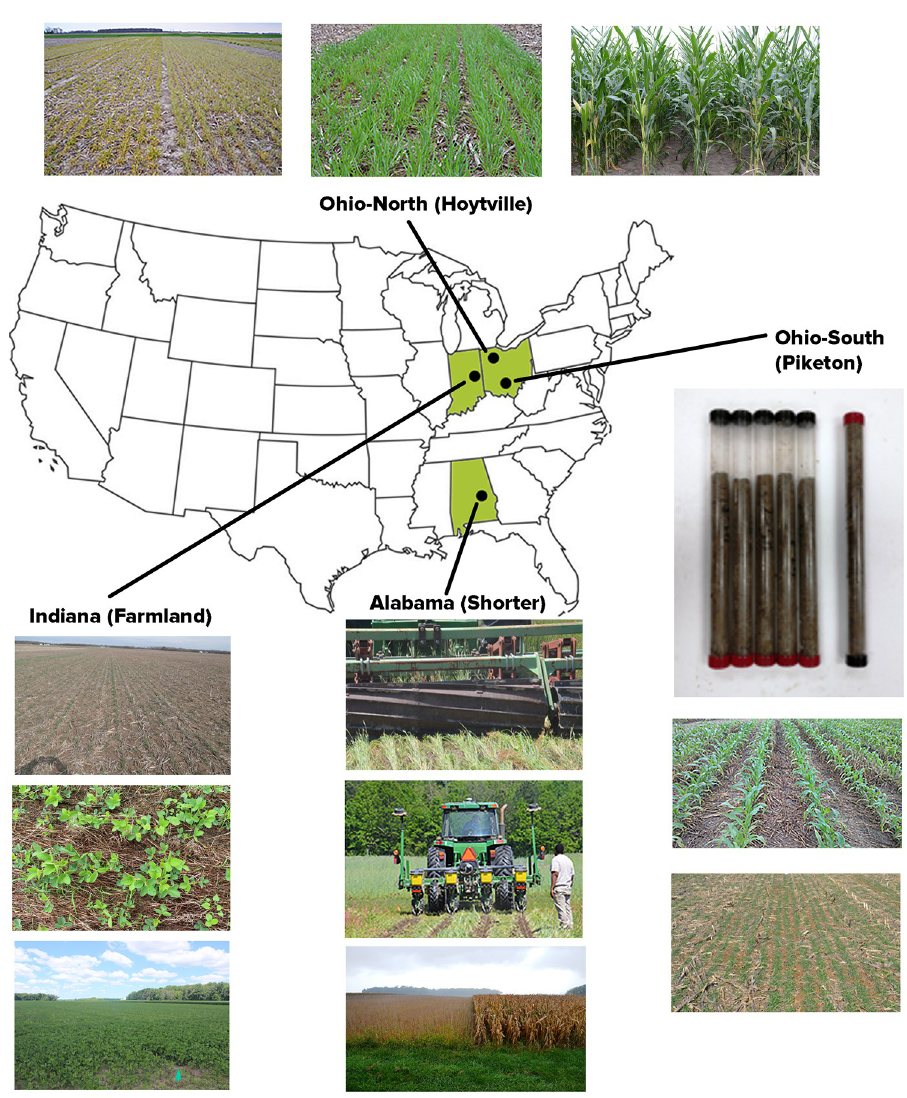
Fig 1. Gypsum, crop rotation and cover crop rainfed field experiments at Alabama (pictures depict crimper rolling of rye winter cover crop followed by plating of corn and soybeans, and matured corn-soybeans before harvesting), Indiana (pictures depict rye as a winter cover crop followed by growing of soybeans within rye mulch, and soybeans at maximum vegetative growth stage), Ohio-north (pictures depict rye as a winter cover crop in early and late spring before planting of corn, and corn at early maturity stage), and Ohio-south (pictures depict rye as a winter cover crop followed by growing of corn within rye residues, and collected soil cores in plastic tubes using the JMC 1 stainless-steel soil environmental probe; https://www.jmcsoil.com) in the U.S. Midwest during 2012 to 2016 (Photos taken by Randall C. Reeder and Khandakar R.